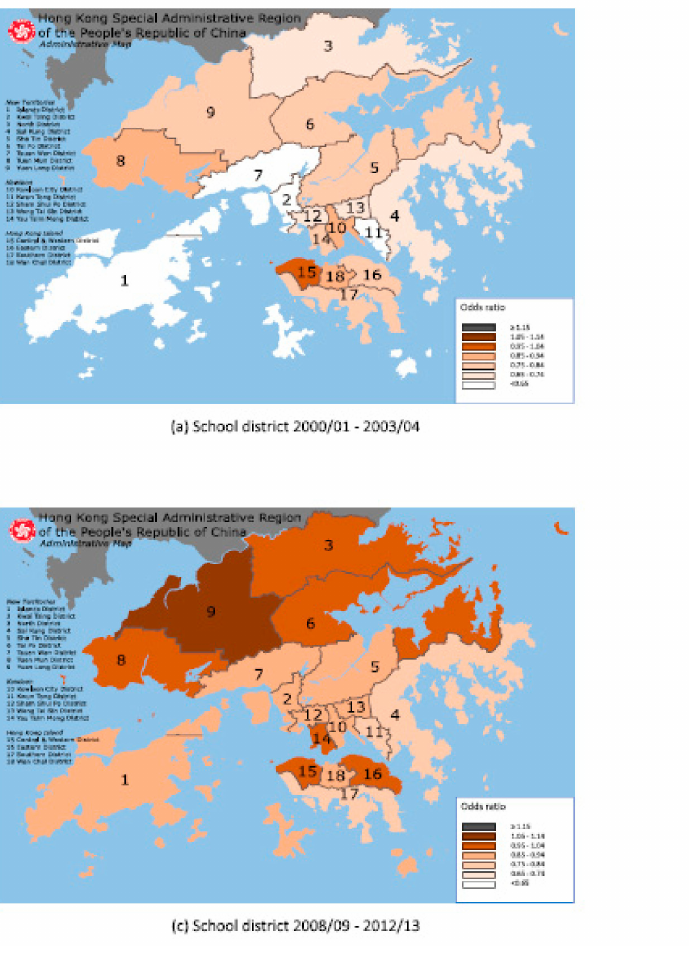
Figure 1. Map of 18 administrative districts in Hong Kong showing the adjusted odds ratio for reduced visual acuity by student’s school district (17 districts relative to Central & Western District) during 2000 / 01–2003 / 04, 2004 / 05–2007 / 08, 2008 / 09–2012 / 13, and 2013 / 14–2016 / 17 (Modified map from original source: Wikimedia Commons (https: // commons.wikimedia.org / wiki /